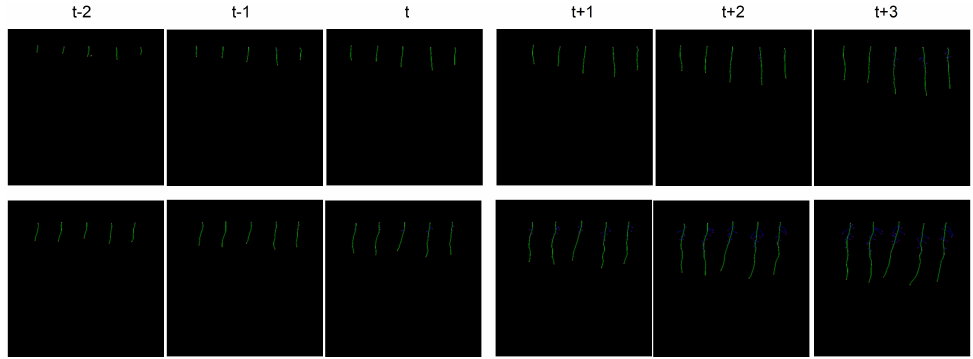
Figure 9. Samples of the results predicted on the Arabidopsis thaliana root dataset.